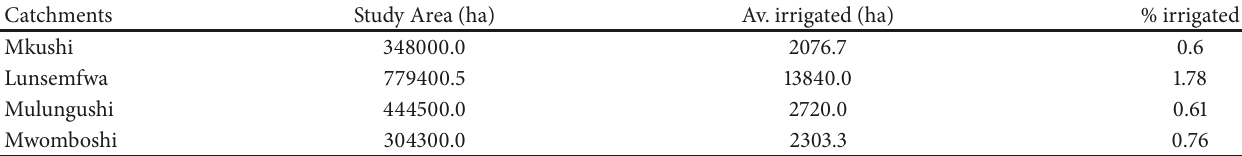
Table 3: Proportion of the various sub-basins under irrigation (wheat/soybean) from 2013 to 2017.